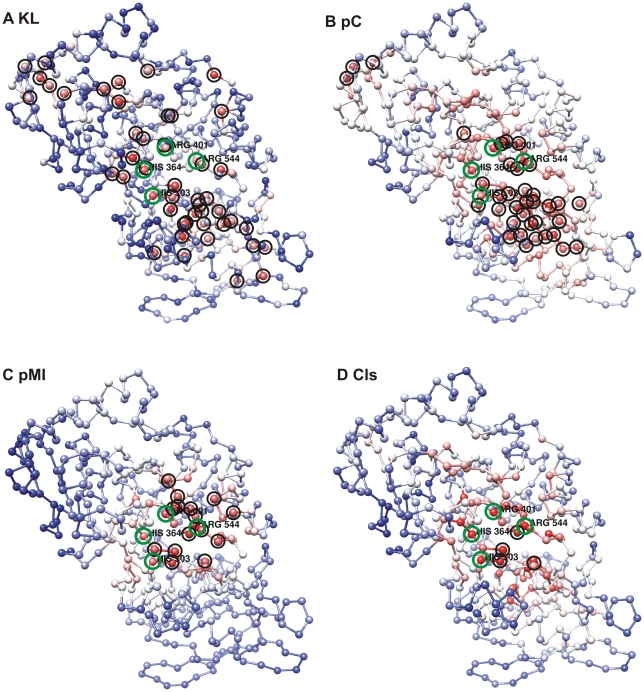
Identification of catalytic residues using four different prediction scores.Plotted is the Cα representation of the PDB entry 1D4C representing the Pfam PF00890 entry. Catalytic residues are encircled in green. The four different prediction scores are shown A) KL Conservation, B) Proximity conservation (pC), C) proximity MI (pMI) and D) Catalytic likeliness score (Cls). Highlighted with black circles are the predicted false positive residues: 47, 39, 15 and 4 respectively. The prediction scores are represented in blue to red scale (blue: lowest; red: highest). Molecular graphics image was produce with UCSF Chimera package. (University of California, San Francisco).